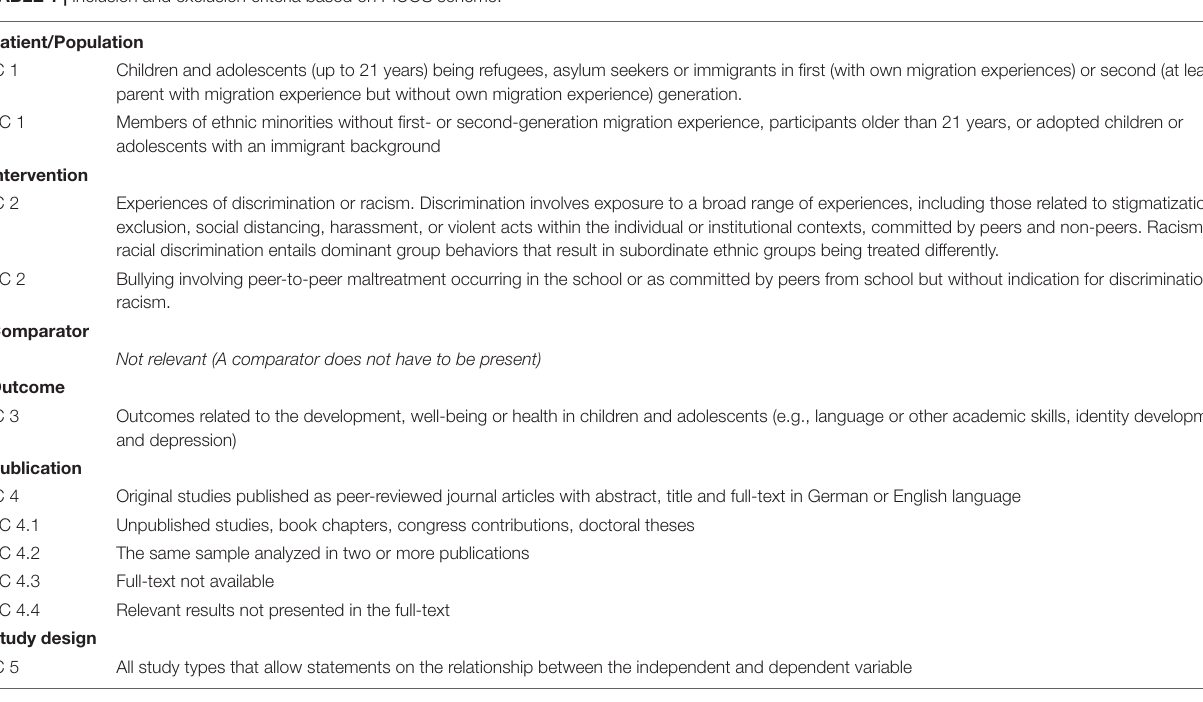
TABLE 1 | Inclusion and exclusion criteria based on PICOS scheme.